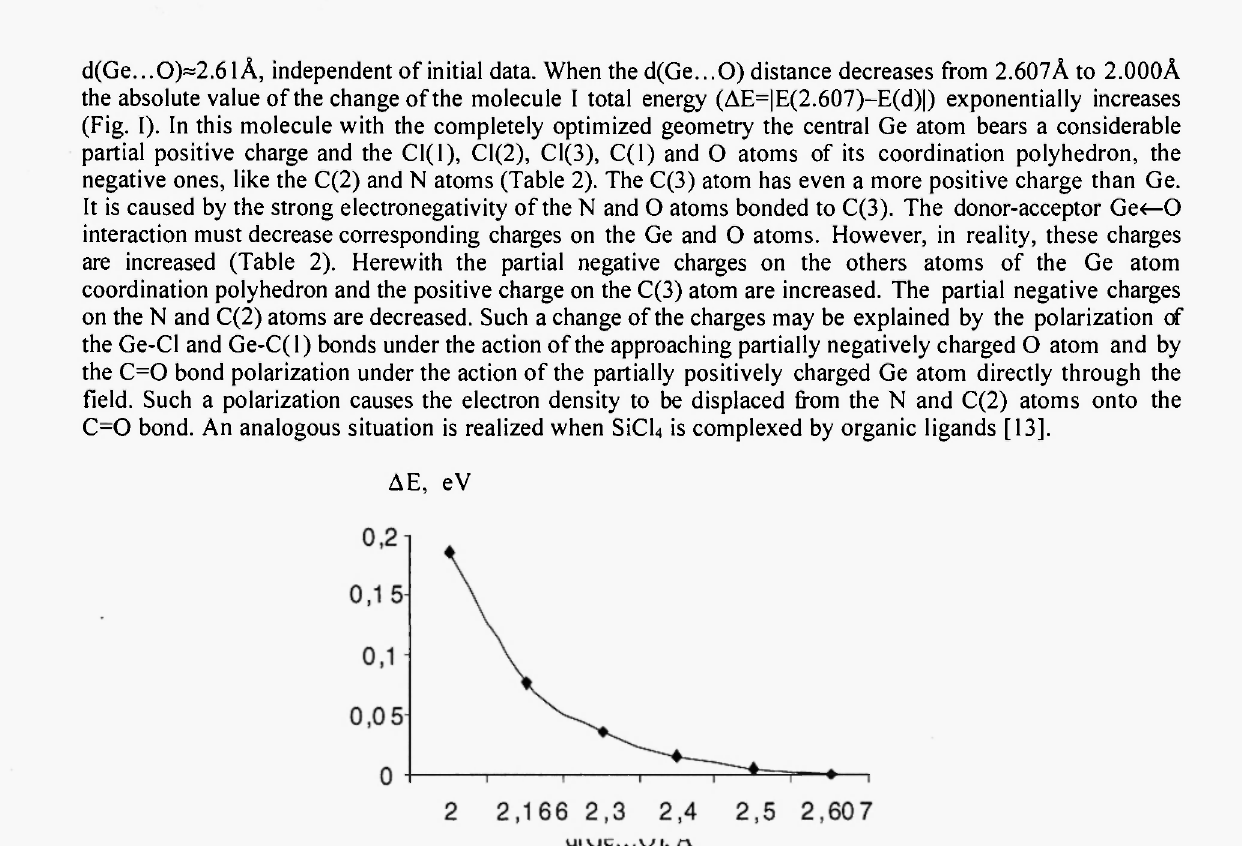
Fig.l. Dependence between the changes of the total energy of the molecule I (AE=|E(2.607)-E(d)|) calculated at the RHF/6-31 G(d) level and the Ge... Ο distance (d(Ge... 0)). Table 2. Charges (q) at the atoms in the molecule I calculated at the RHF/6-3 lG(d) level and different distances